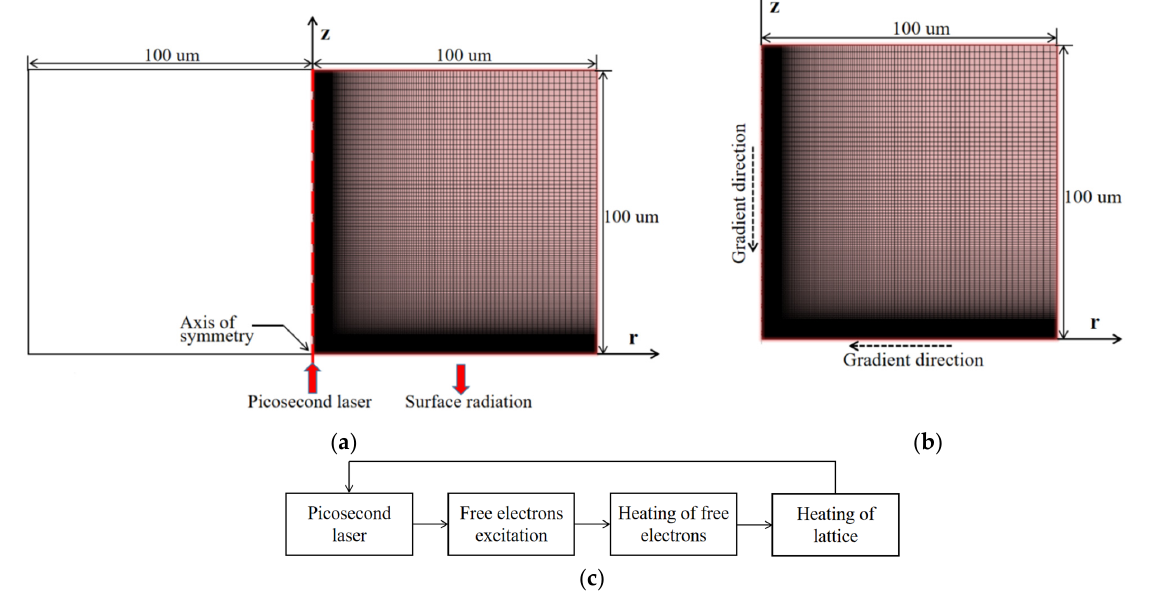
Figure 1. Simulation model. ( a ) boundary condition; ( b ) mesh division; ( c ) the solution process. The solution process is shown in Figure 1c. The specific simulation steps are as fol-